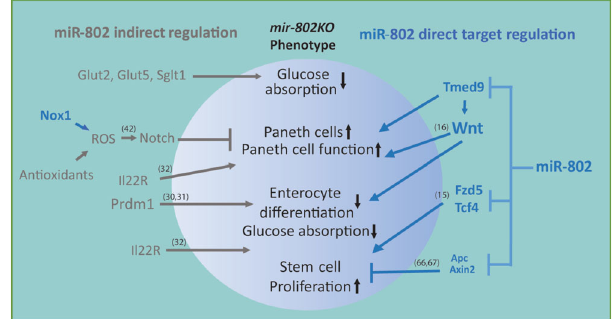
Fig. 7 Schematic representation of a model depicting direct and indirect mechanisms of miR-802 action in intestinal epithelium homeostasis. Blue arrows indicate fi ndings made in this study, previously reported regulatory pathways are shown in gray and